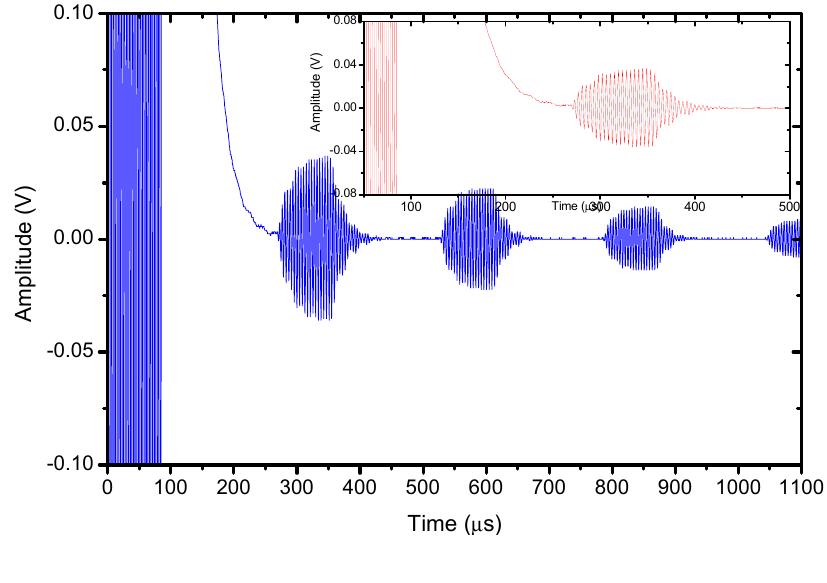
Figure 18. Pulse-Echo mode of operation, narrow band excitation (tone burst). Conventional air-coupled transducer with passive matching layers (compare with Figures 13 and 14). Reflector at 45